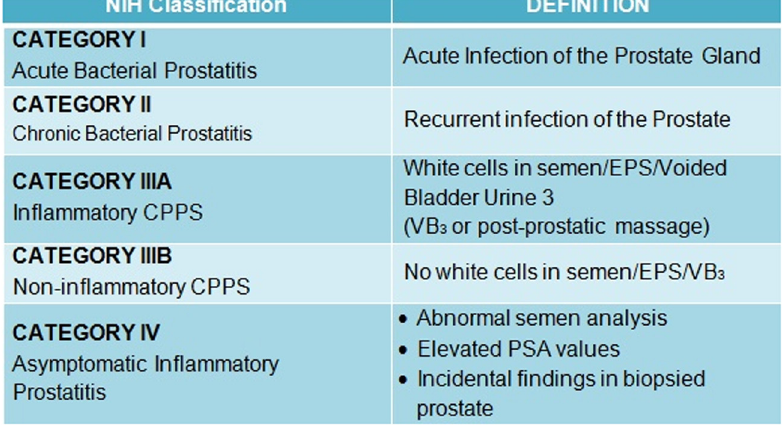
Figure 1: Prostatitis classi fi cation of the